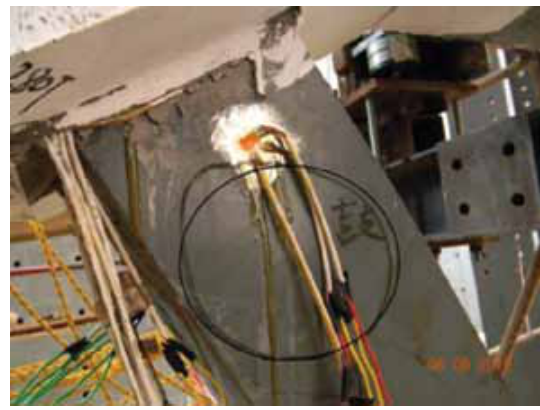
Fig. 7. Buckling of ZHJD-1 compressive web member P = 3800 kN